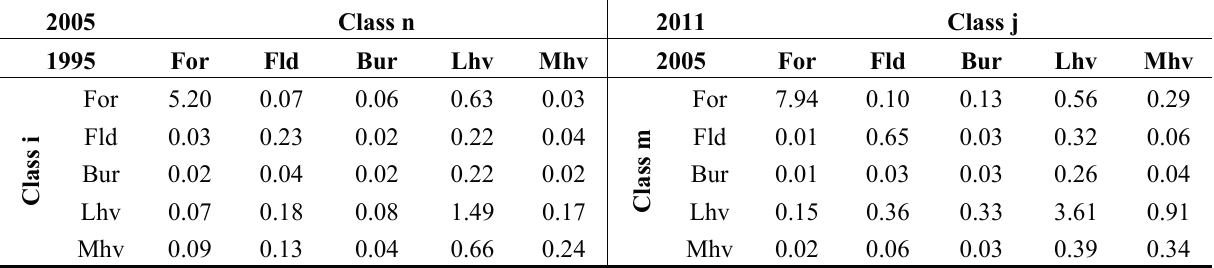
Table 5. LC change matrix for two intervals: 1995–2005 ( left ) and 2005–2011 ( right ), in percentage of the total analysed area per